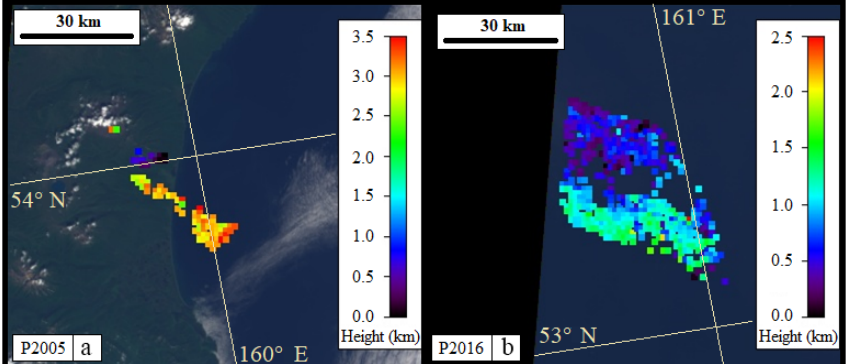
Figure 4. MISR stereo height retrieval maps derived using the MISR INteractive eXplorer (MINX). Class 3 plumes (high MeNspWab) emitted from Karymsky volcano on (a) 28 August 2005 (orbit: 30285; path: 97; block: 47) and (b) 6 October 2016 (orbit: 89365; path: 96; blocks: 47–48). Note that the elevation scales vary from panel to